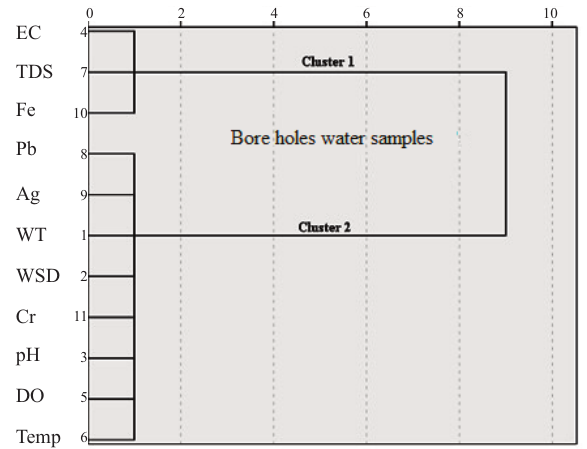
Fig. 5. HCA dendrogram (using Ward Linkage) of BH water parameters.